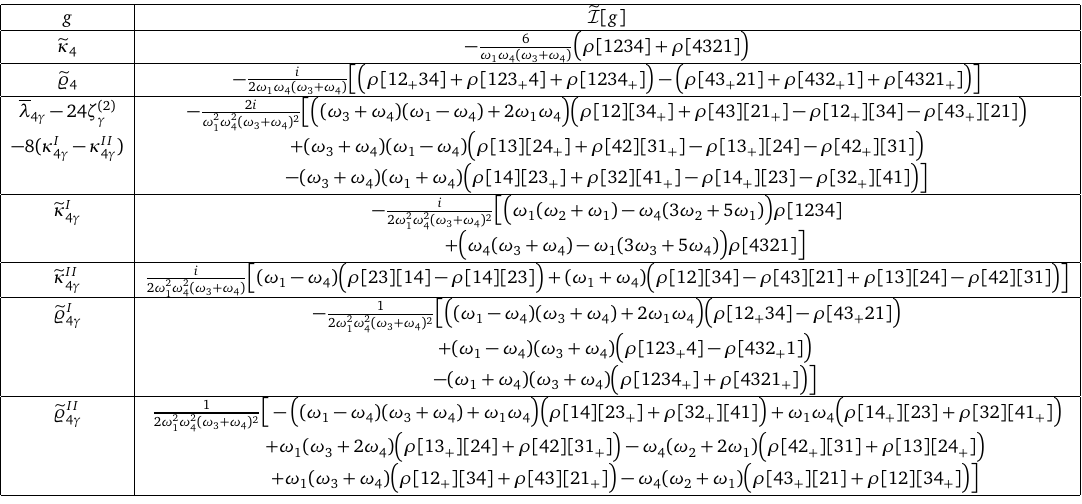
Table 3: Couplings with odd parity under